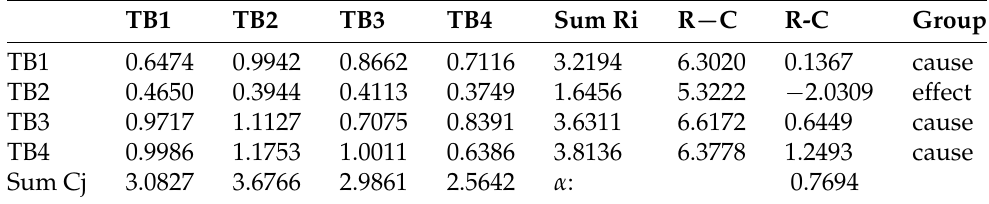
Table 14. Total relation and direct–indirect influence matrix for technological and system sub-barriers.